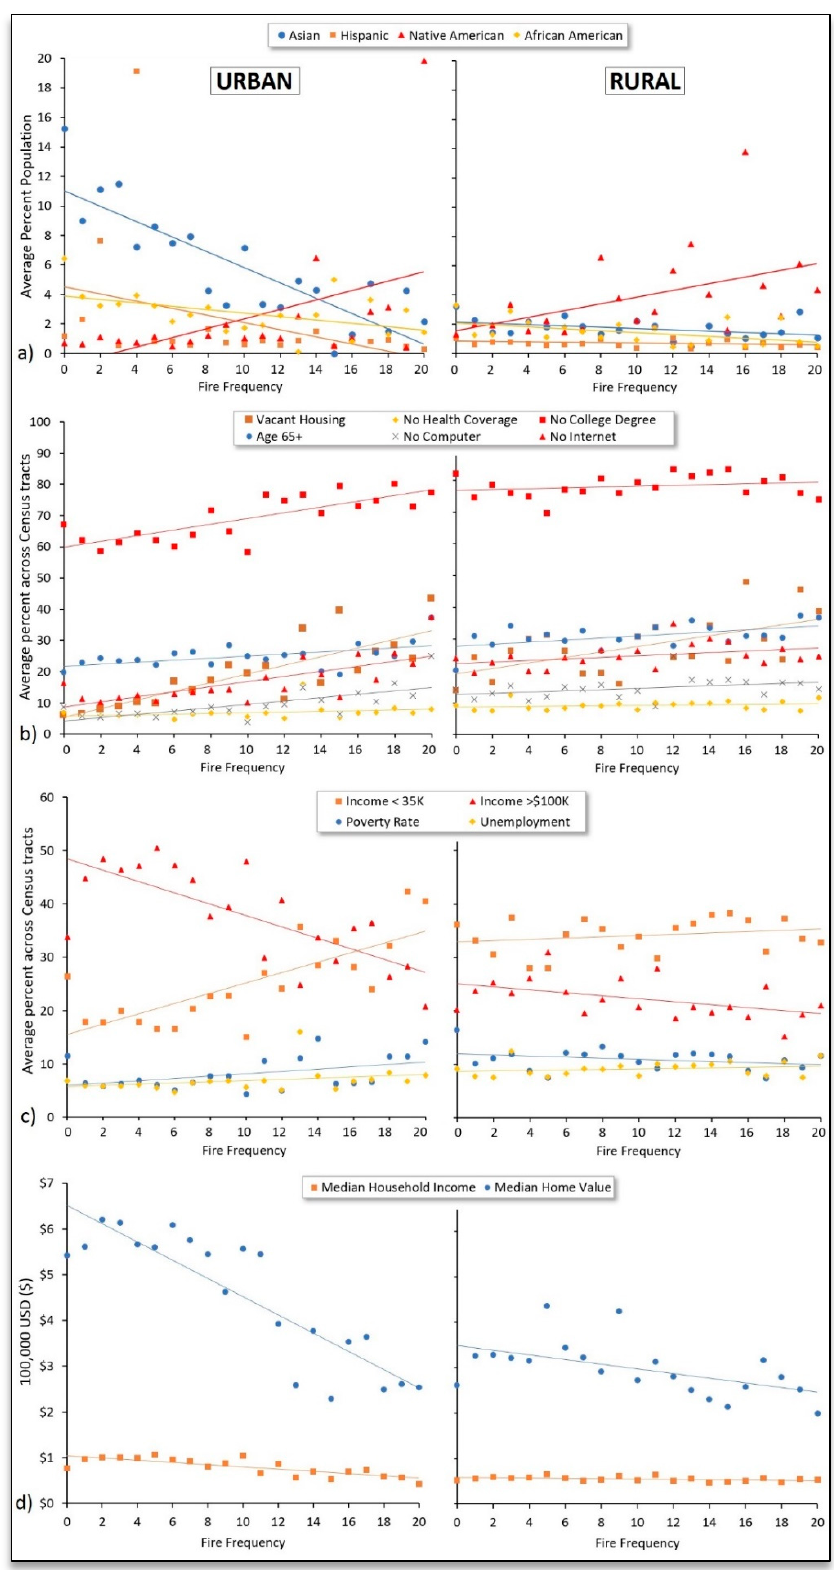
Figure 4. Percentage of ( a ) minority populations, ( b ) wildfire vulnerability indicators, and ( c , d ) economic indicators averaged across Census tracts grouped by fire frequency.